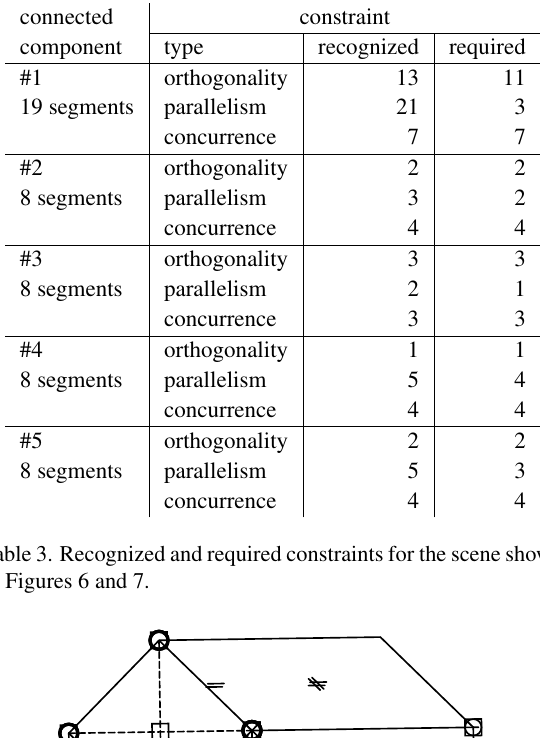
Figure 6. Brightened true orthophoto of an urban scene with superimposed outlines obtained by the recognized constraints ( (cid:50) , (cid:107) , (cid:12) ) and subsequent adjustment.